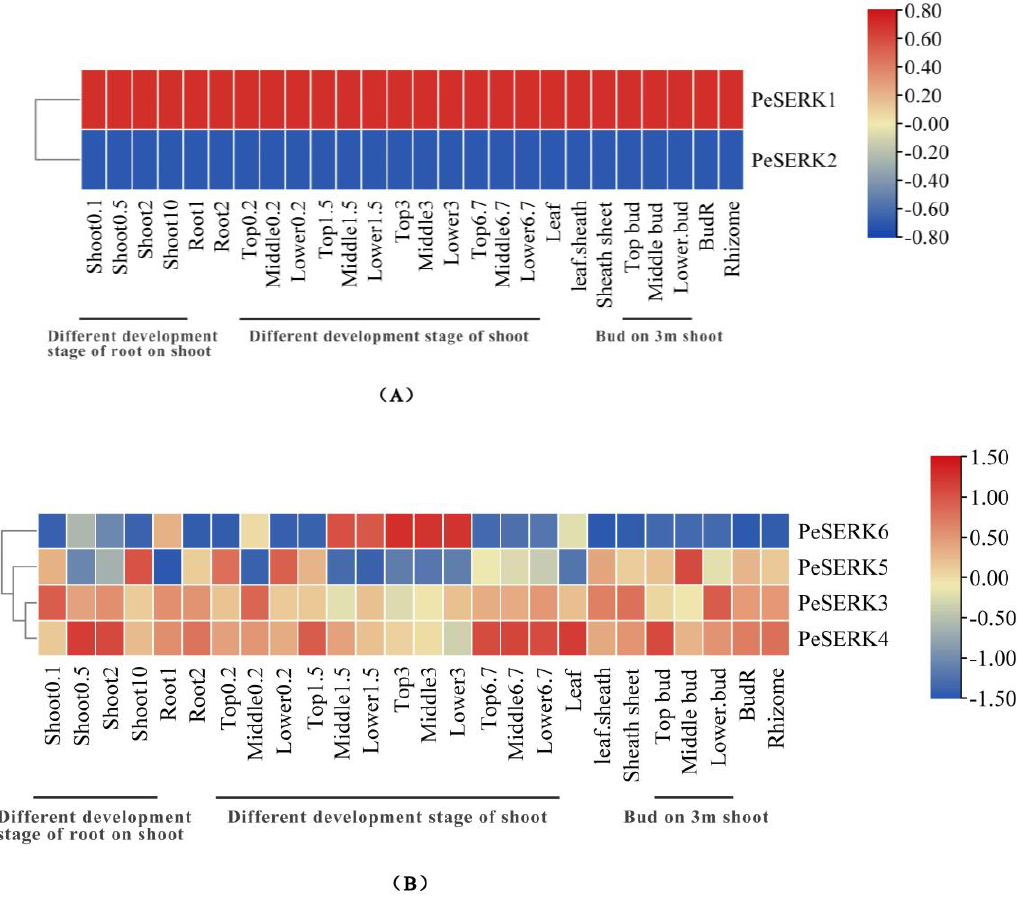
Figure 7. Expression patterns of PeSERKs in different tissues of moso bamboo. ( A ) Differential expression patterns of PeSERK1 and PeSERK2 in development stages of root on shoot, development stages of shoots, root on rhizome, bud on 3 m shoot, BudR, rhizome, leaf and leaf sheath. ( B ) Differential expression patterns of PeSERK3, PeSERK4, PeSERK5 and PeSERK6 in development stages of root on shoot, development stages of shoots, root on rhizome, bud on 3 m shoot, BudR, rhizome, leaf and leaf sheath. The development stages of root on shoot (0.1, 0.5, 2 and 10 cm shoot), development stages of shoots (top 0.2 m, middle 0.2 m, lower 0.2 m, top 1.5 m, middle 1.5 m, lower 1.5 m top 1.5 m, top 3 m, middle 3 m, lower 3 m top 6.7 m, middle 6.7 m and lower 6.7 m), root on rhizome, bud on 3 m shoot (top bud, middle bud and lower bud), BudR, rhizome, leaf and leaf sheath.